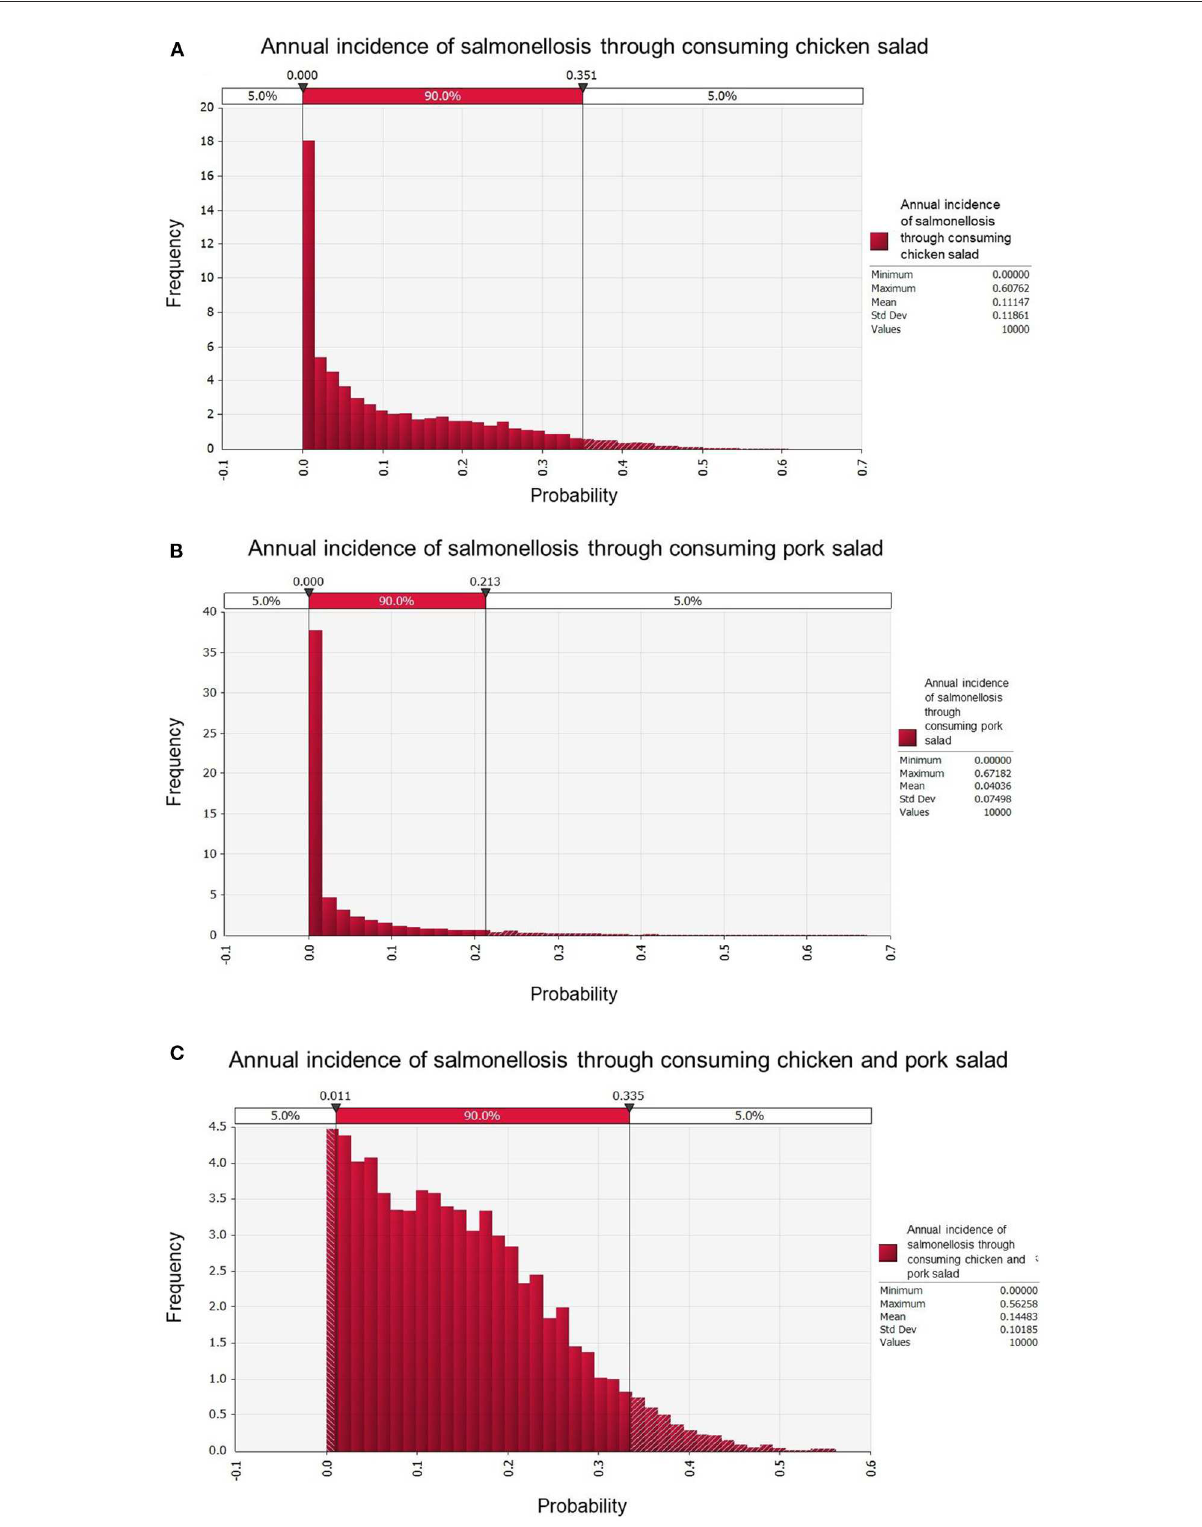
FIGURE2 Annual incidence rates of salmonellosis in Cambodian households eating chicken salad (A) , pork salad (B) , and both chicken and pork salad (C)